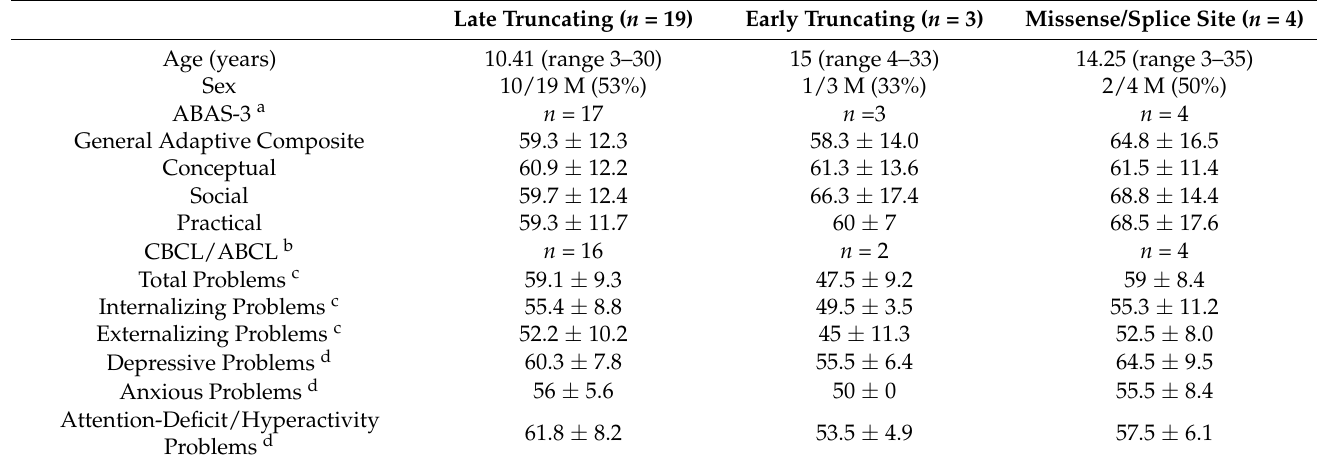
Table 1. Adaptive and Behavioral